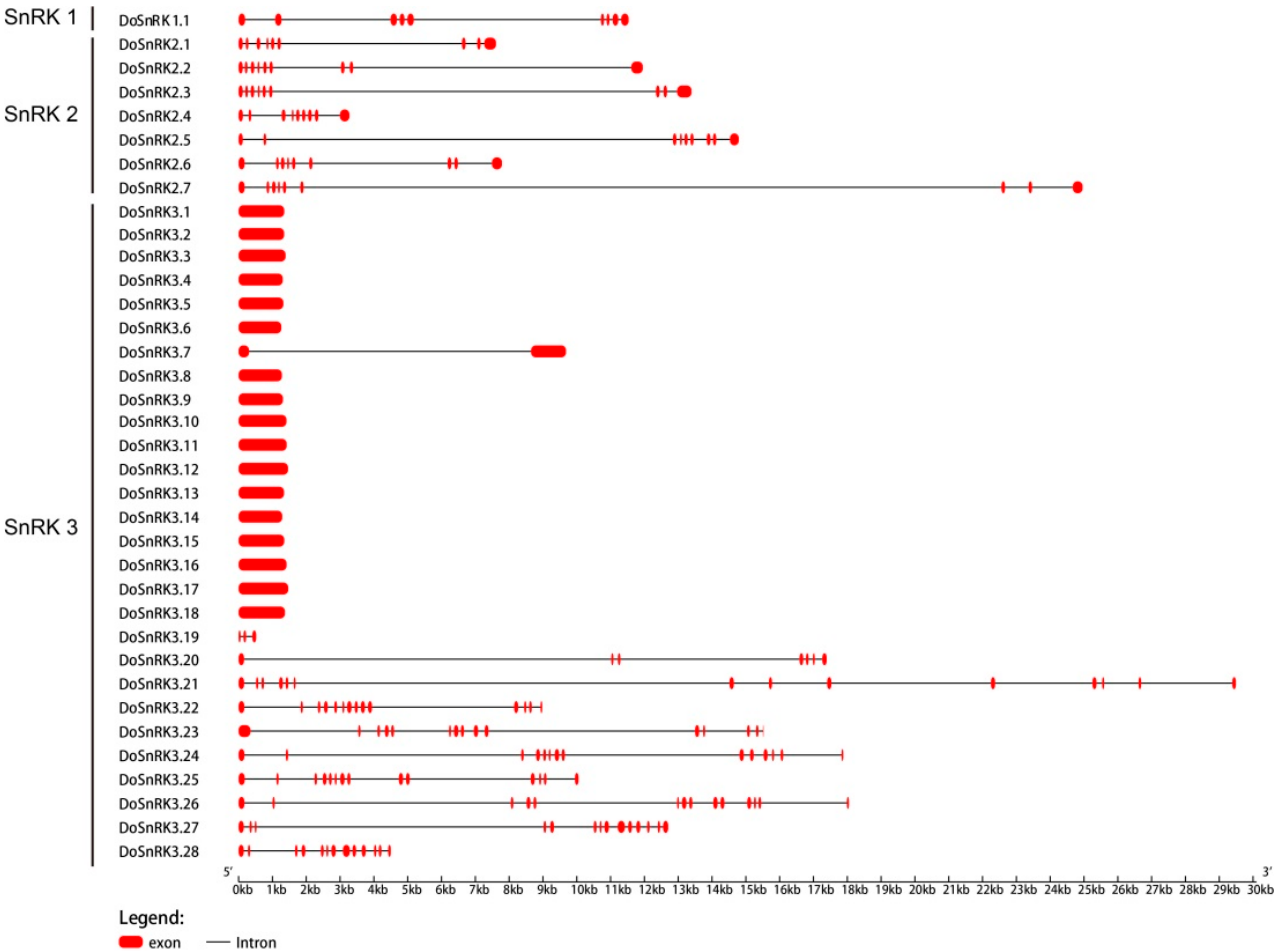
Figure 2. Gene structures of DoSnRK genes in D. officinale .